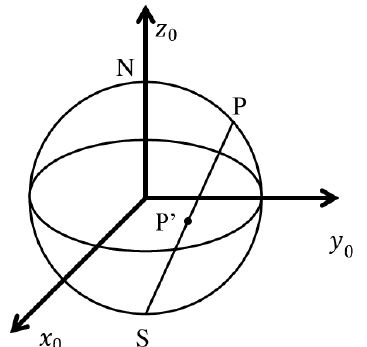
Figure 1. Stereographic projection: the point P of coordinates ( x 0 , y 0 , z 0 ) on the sphere is projected on P’ of coordinates ( x , y ) on the plane. N and S denote respectively the north and south poles. (Reproduced with permission from